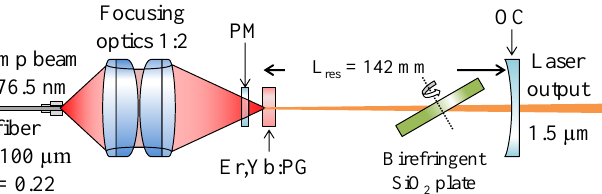
Figure 2. The experimental arrangement of a tunable laser based on the investigated glasses.